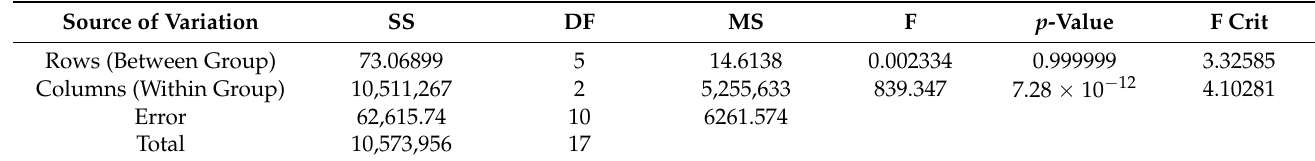
Table 12. ANOVA for bulk density—E series (POS, SFA, LWC).